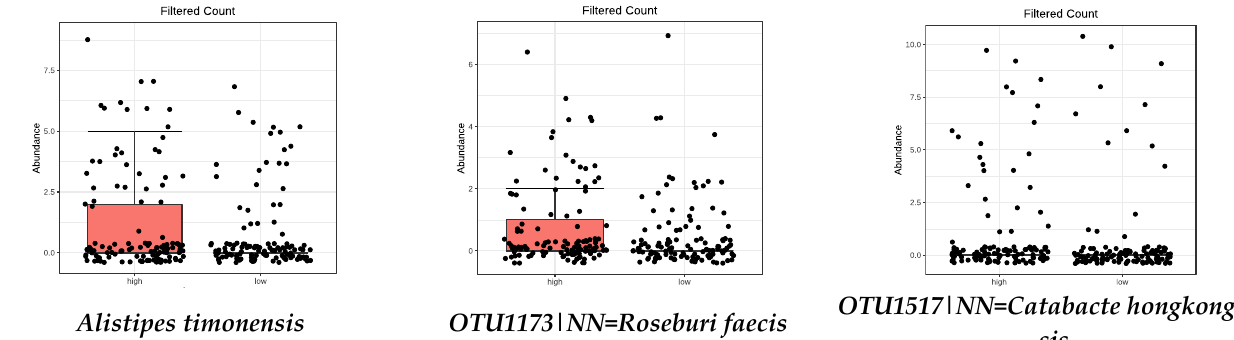
Nutrients 2021 , 13 , x FOR PEER REVIEW Figure 5. Bacterial species that were significantly more abundant in the group with high FRUIT intake (FDR < 0.05) by metagenomeSeq test. Red boxes represent participants with a higher adherence to the MD and blue boxes low adherence.